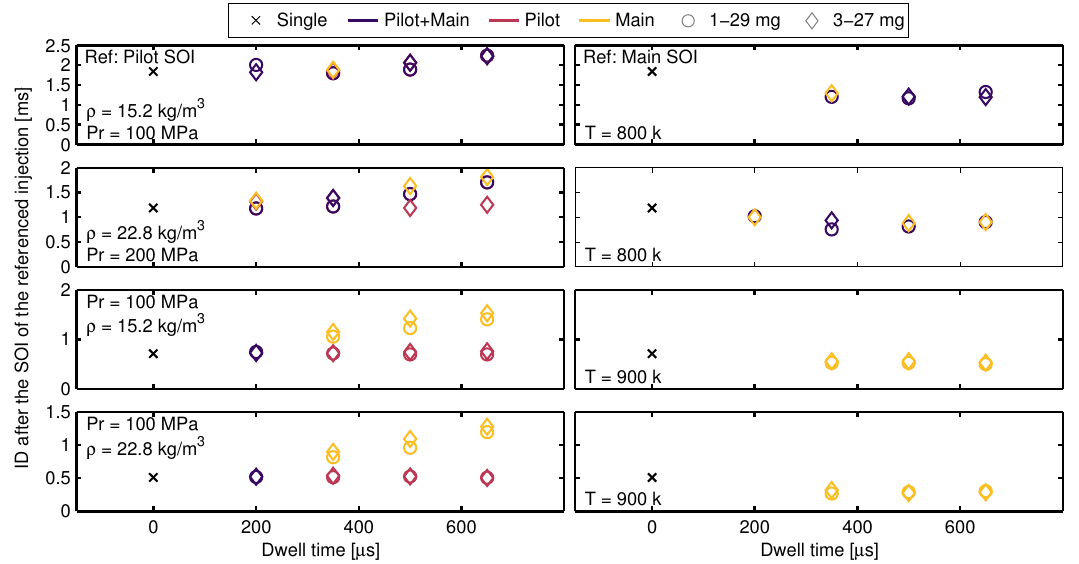
Figure 9. Ignition delay results for a pilot-main strategy chamber temperature of 800 K (upper two rows) and 900 K (lower two rows). Pilot + main refer to the cases when the pilot and main ignited simultaneously. Values are referenced to the start of injection of either the pilot (left column) or main (right